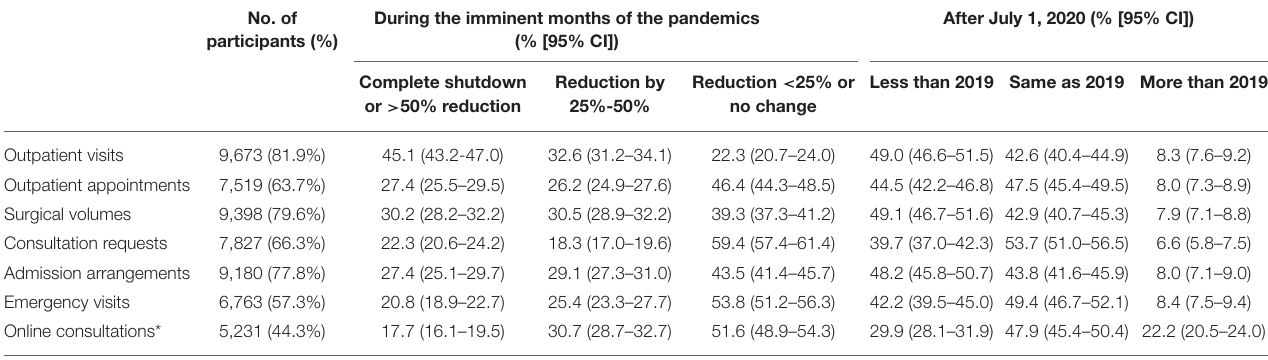
TABLE 2 | Changes in clinical activities during the